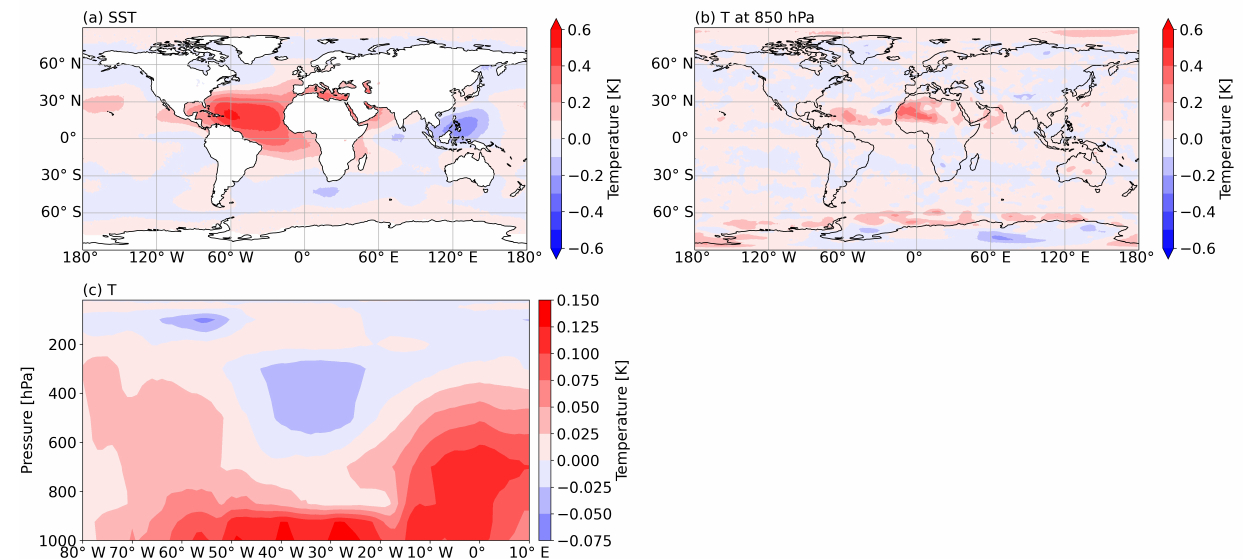
Figure 12. Mean analysis difference (AER minus CTL) on ( a ) sea surface temperature, ( b ) 850 hPa temperature, and ( c ) cross section of temperature meridional mean from 0